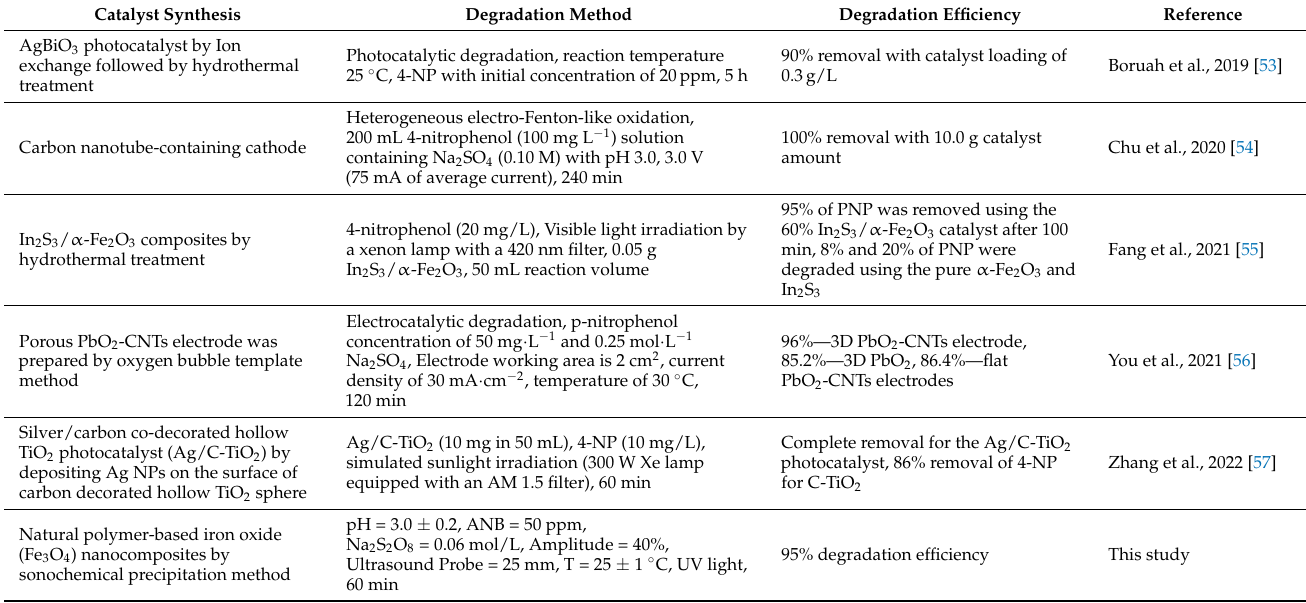
Table 1. Comparative results of 1-amino-nitrobenzene (ANB) degradation with the reported literature.